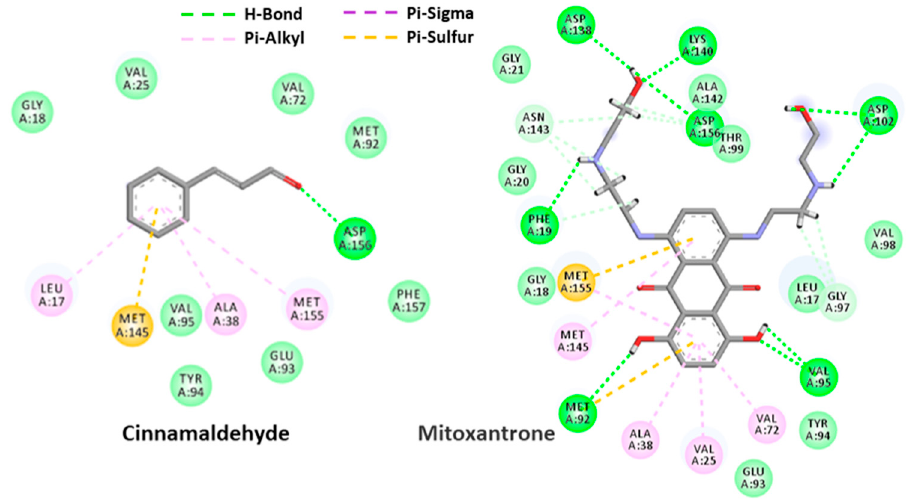
Figure 9. Surface view ( up ) and 3D structure view ( down ) of the co-crystalized mitoxantrone in the active site of PknB [22].